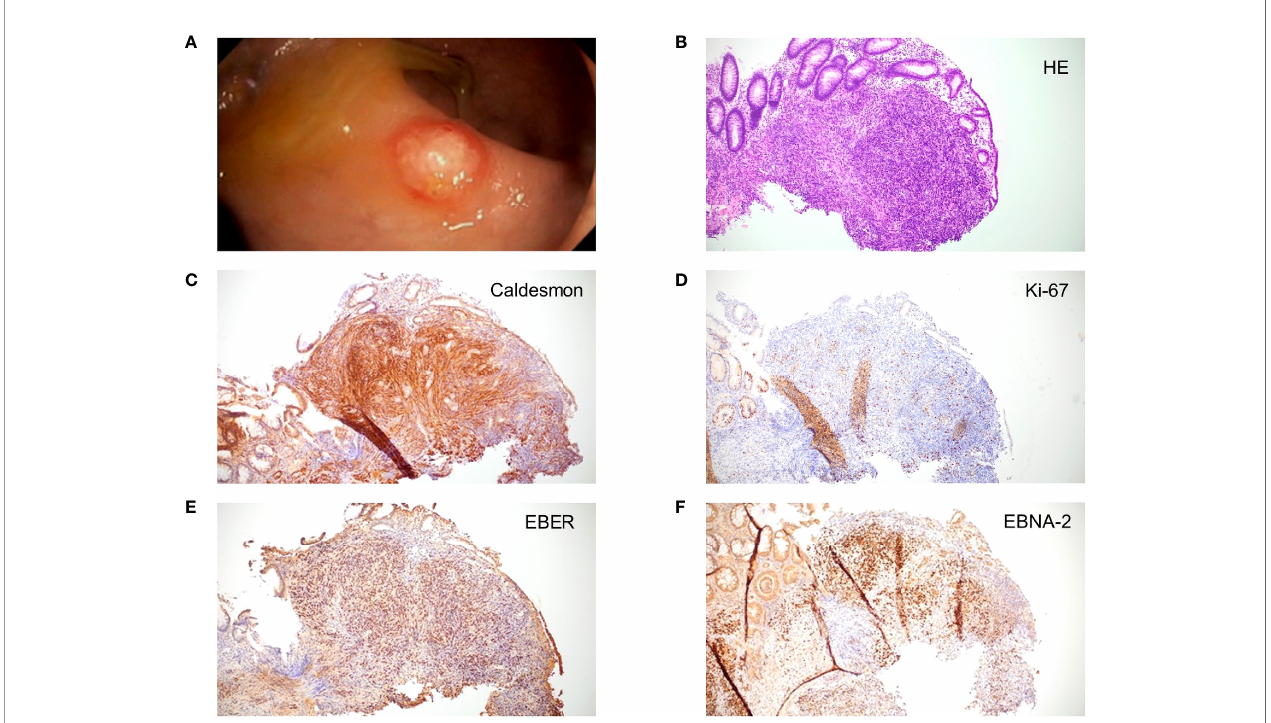
FIGURE 2 | Macroscopic and microscopic images of posttransplant smooth muscle tumor (PTSMT). (A) Colonoscopic image of PTSMT depicted as a nodular mucosal tumor with erythematous margin and a mucous cap. (B – F) Histopathological stainings from the tumor depicted in panel (A) , ×100 magni fi cation applied. Staining: (B) hematoxylin and eosin stain; (C) caldesmon stain; (D) Ki-67 stain; (E) Epstein – Barr virus-encoded small RNAs (EBER) in situ hybridization; (F) Epstein – Barr virus nuclear antigen 2 (EBNA-2) stain.